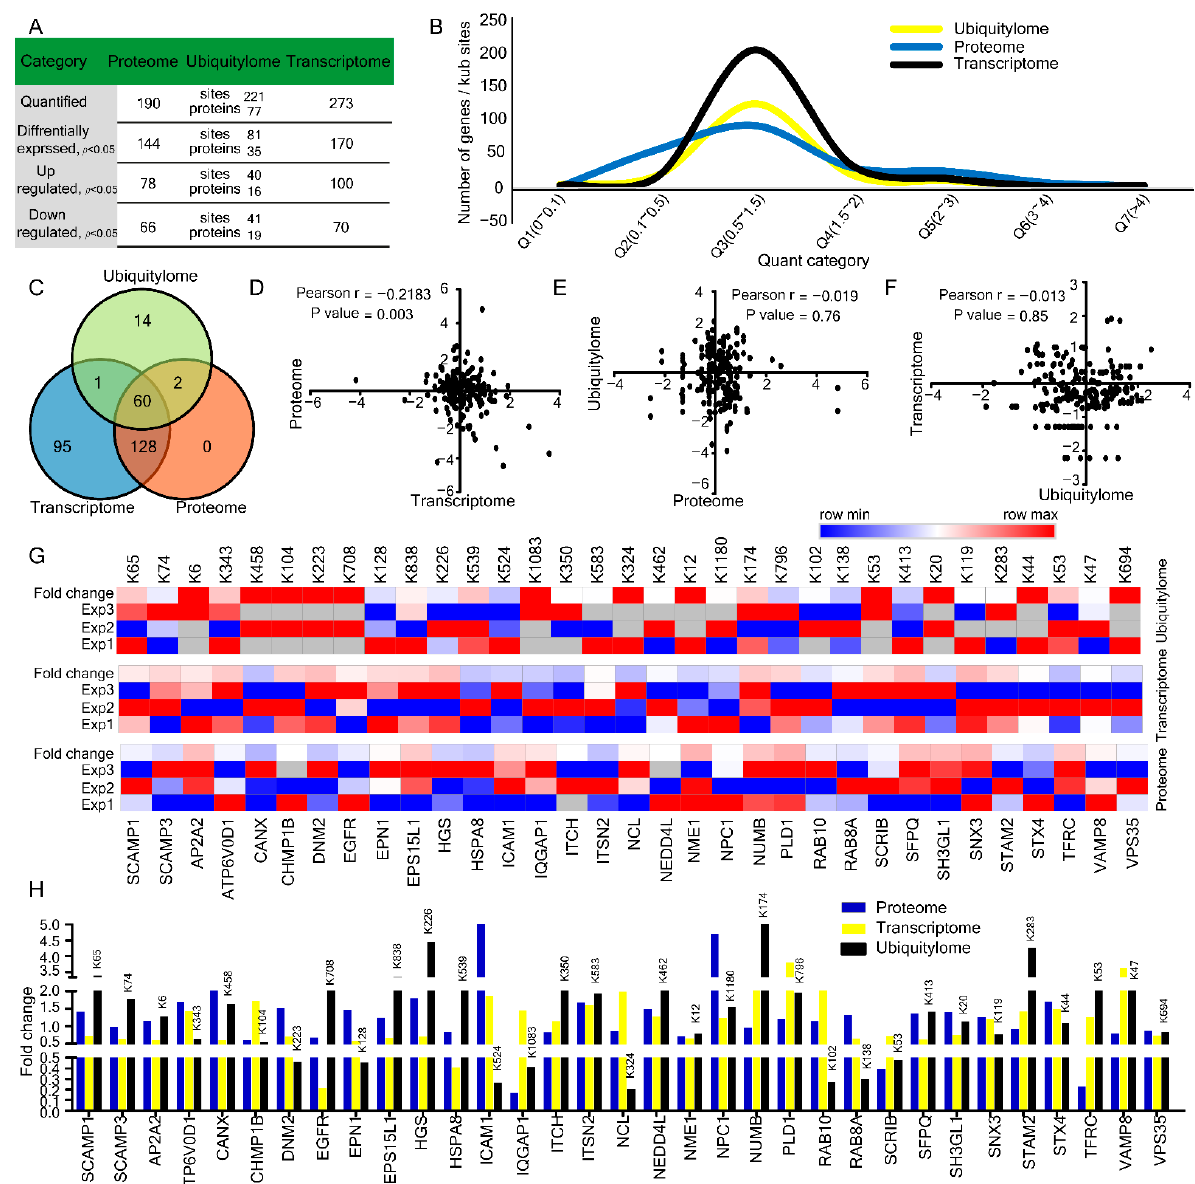
Figure 4. Comparison and correlation of transcriptome, proteome, and ubiquitylome changes. ( A ) Summary of quantified and differentially expressed genes, proteins, and Kub-sites. ( B ) Com- parison of the distribution of quantified transcriptome, proteome, and ubiquitylome. ( C ) Venn diagrams represent common gene presentation across transcriptome, proteome and